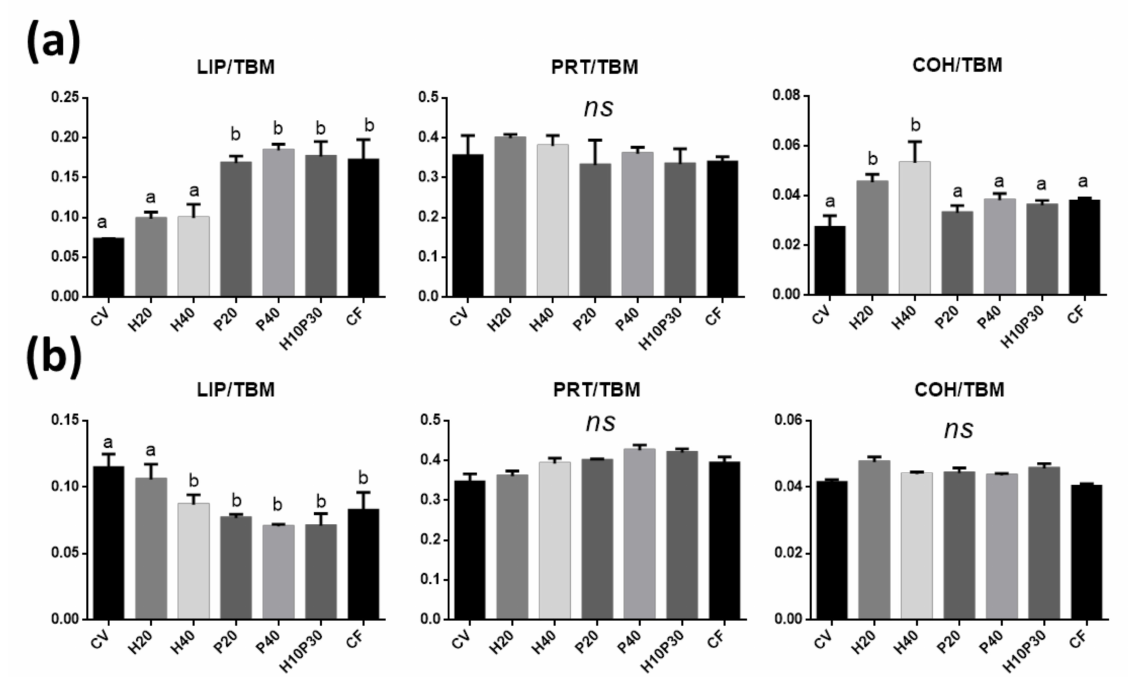
Figure 6. Biochemical composition of medium ( a ) and distal ( b ) intestine mucosa. Statistical analysis of the following band area ratios: LIP/TBM (relative amount of total lipids), PRT/TBM (relative amount of total proteins), and COH/TBM (relative amount of glycosylated